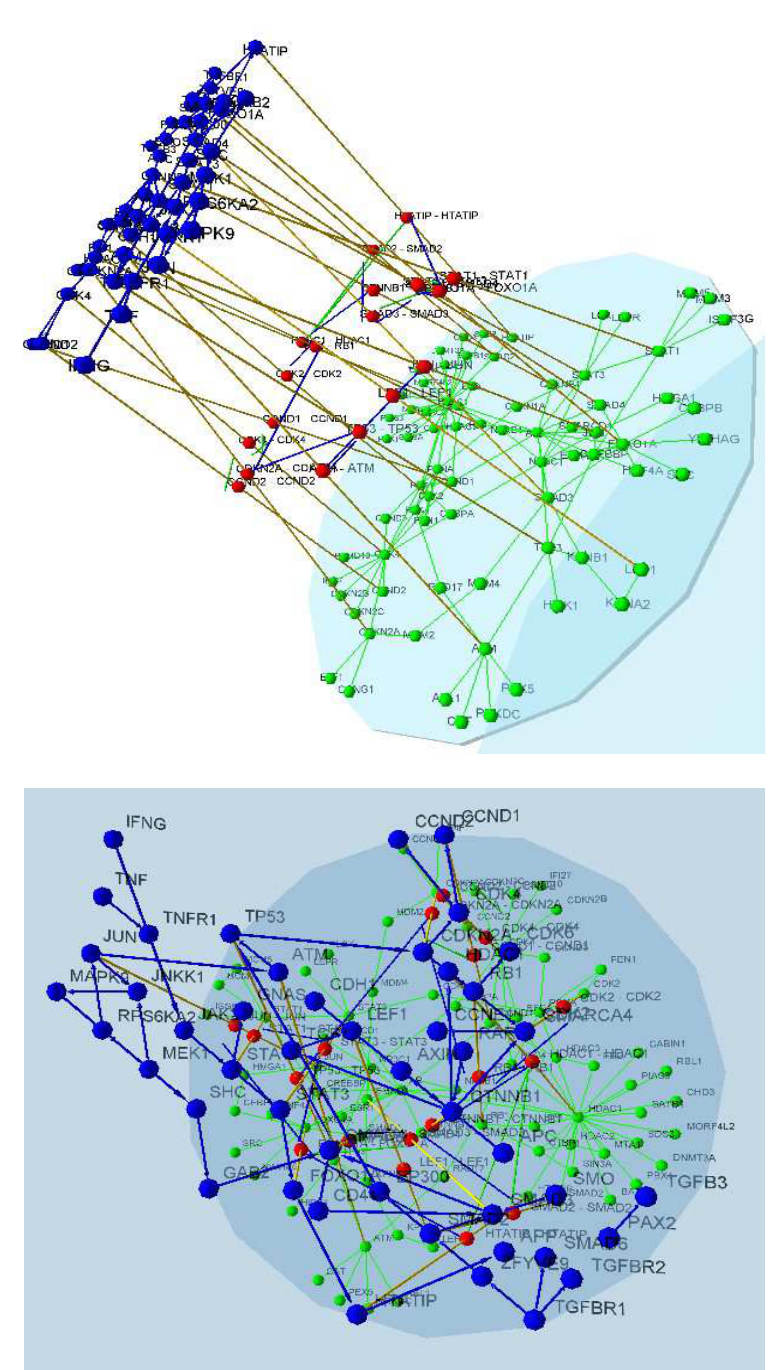
Figure 7: Visualisation of the two overlapping networks representing a signal transduction net- work ( TGF β ) and a corresponding part of a nuclear protein interaction network. The signal transduction network is in blue, whereas the protein interaction network is in green. The proteins co-shared by both networks are in